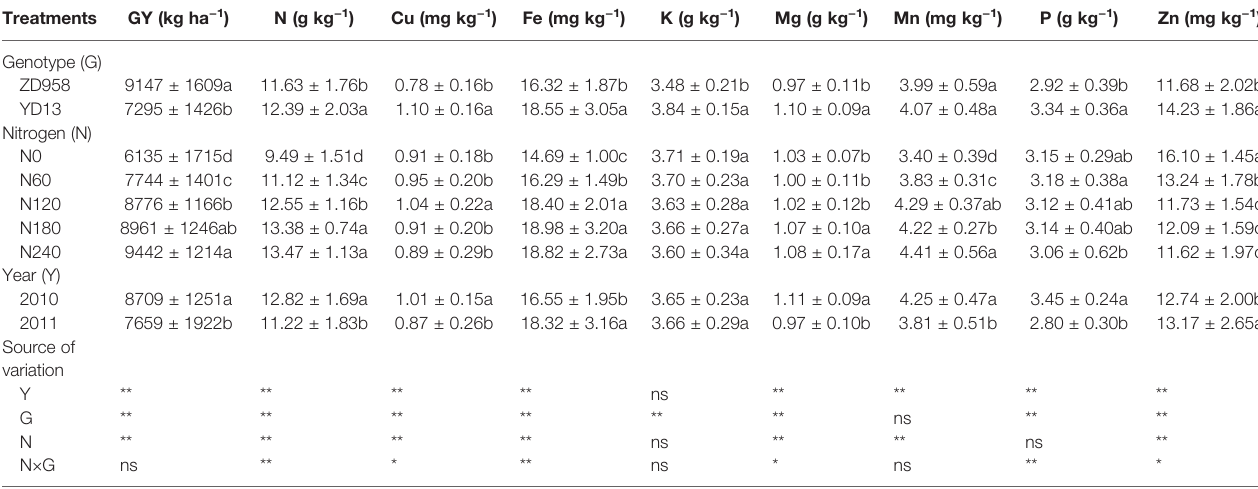
TABLE 5 | Variance analysis (ANOVA) of the effects of year (Y), nitrogen (N) and genotypes (G) on maize grain yield and grain mineral nutrients (N, Cu, Fe, K, Mg, Mn, P and Zn) concentration (FJJ).